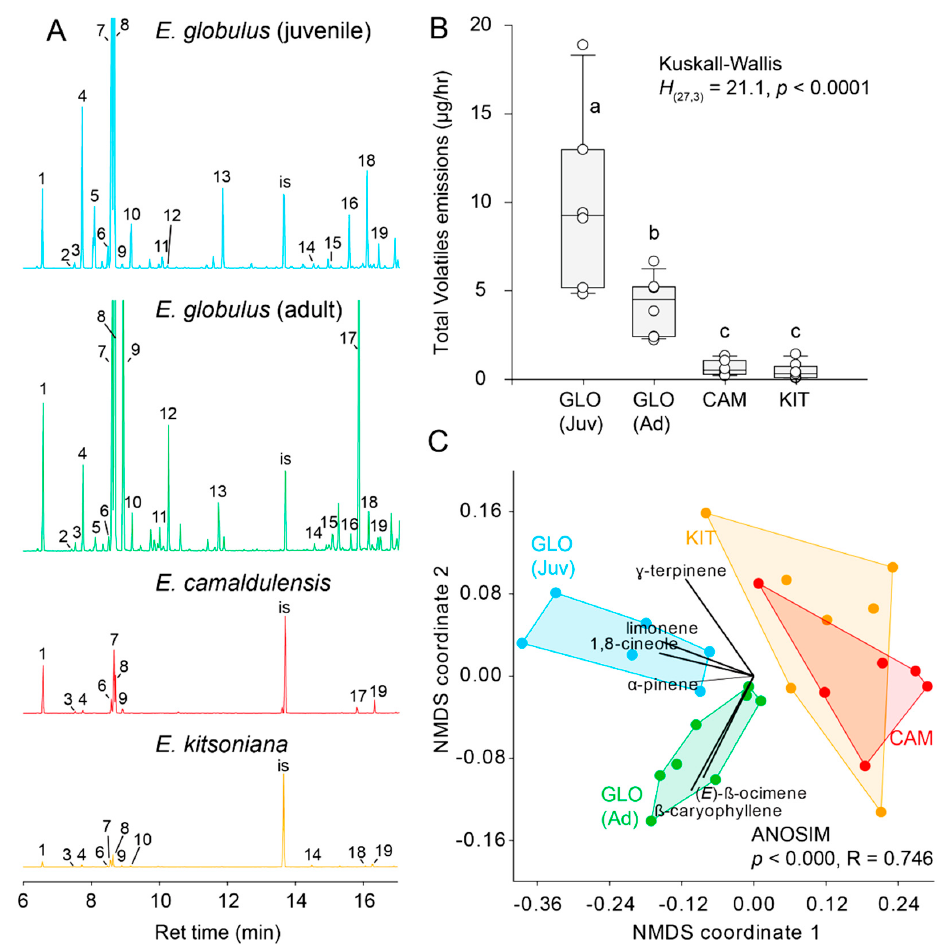
Figure 3. ( A ) Chromatograms of HPVs of leaves of E. globulus (juvenile and adult), and young E. camaldulensis and E. kistoniana leaves. Numbers correspond to the main components of the